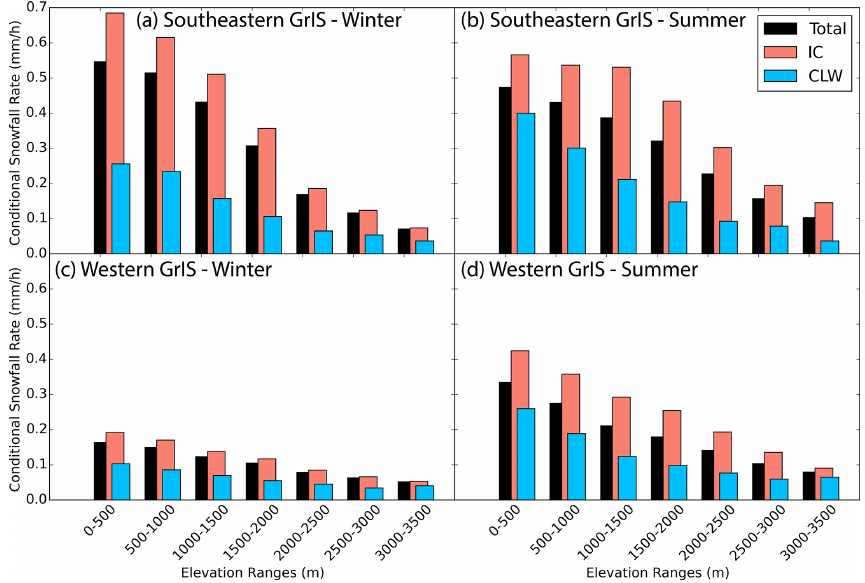
Figure 4. As in Fig. 3 but with conditional snowfall rate. This is the mean rate of snowfall for all snowfall observations of a given